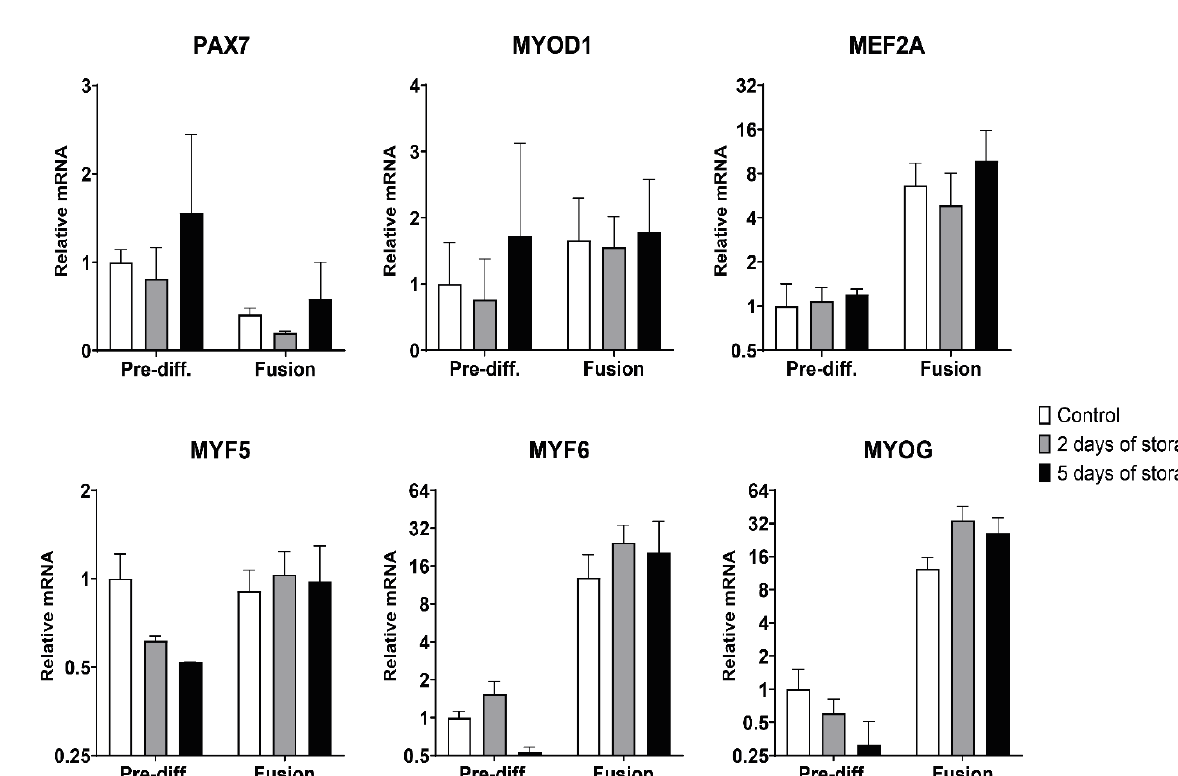
Figure 4. Quantitative RT-PCR analysis of myogenic gene expression before and after fusion. Pre-diff.: pre-differentiated. Total RNA was isolated from pre-differentiated (Pre-diff.) satellite cells and after they had undergone fusion, which was used in a two-step reverse transcriptase-qPCR (RT-qPCR) to quantify mRNA expression of the specific myogenic transcription factors: PAX7 (paired box 7), MYOD1 (myogenic differentiation 1), MEF2A (myocyte enhancer factor 2A), MYF5 (myogenic factor 5), MYF6 (myogenic factor 6) and MYOG (myogenin). The data is presented as relative mRNA levels (relative to pre-differentiated control samples). The Y-axis is log2 scaled. The data is presented as mean ±SEM based on three cows (n = 3), except for the 5 days of storage data which is from only two cows (n = 2).